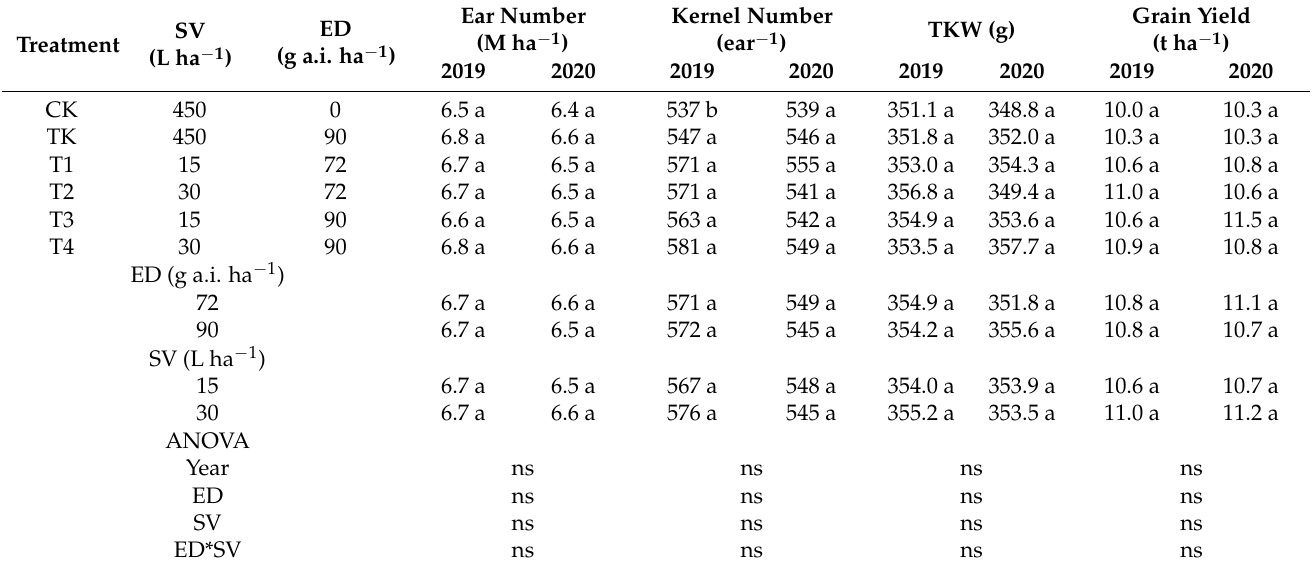
Table 3. The results of yield, yield components, and significance analysis of spray volume and EDAH dosage for the UAV